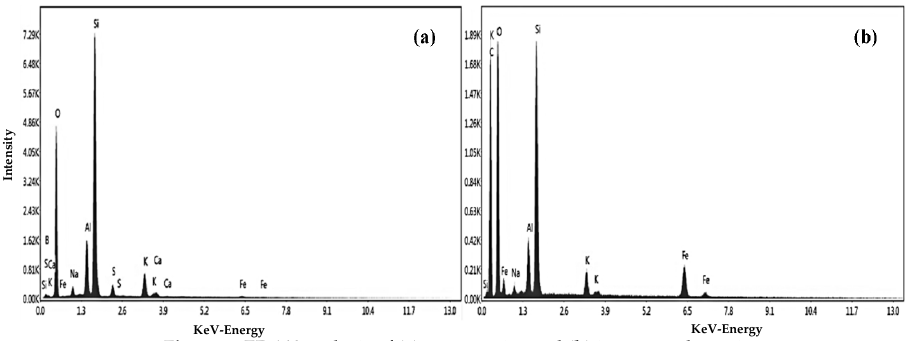
Figure 1. EDAX analysis of ( a ) raw pumice and ( b ) iron coated pumice.